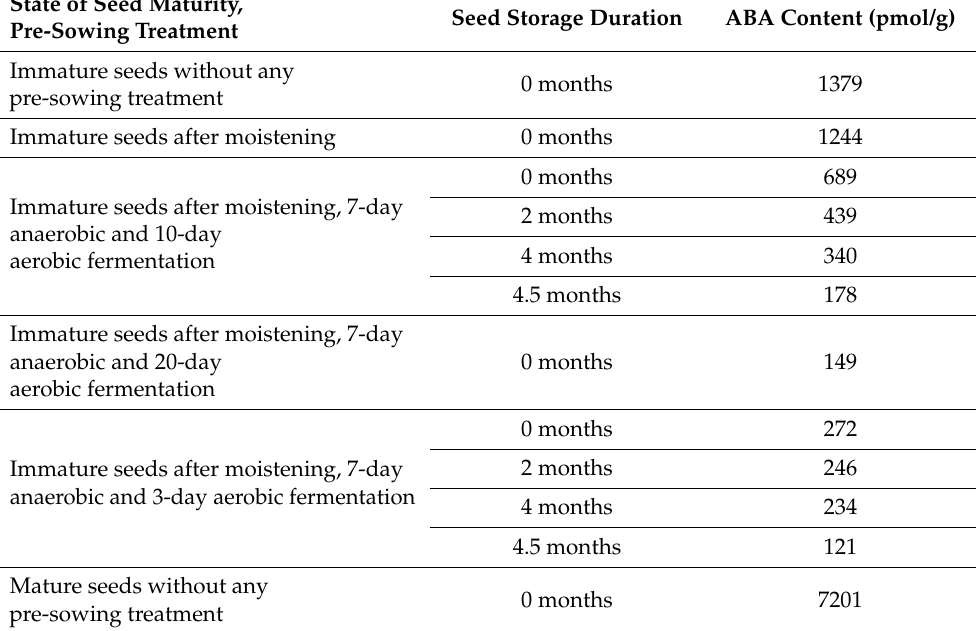
Table 3. Content of abscisic acid in the seed of Uhersk é Hradištˇe origin after its collection in the state of immaturity, after its moistening and fermentation, during storage and after collection in full maturity (Experiment